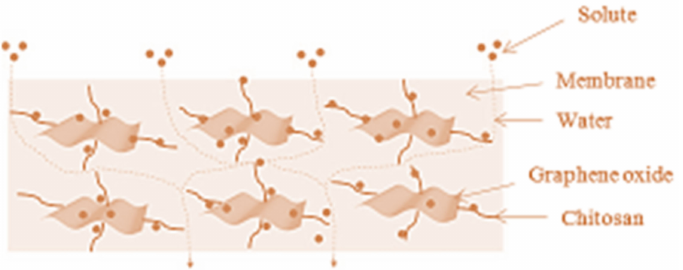
Figure 16. Graphene oxide–chitosan dispersion in water filtration membrane and its feed transport route. Reprinted from [42]. Copyright 2018 with permission from